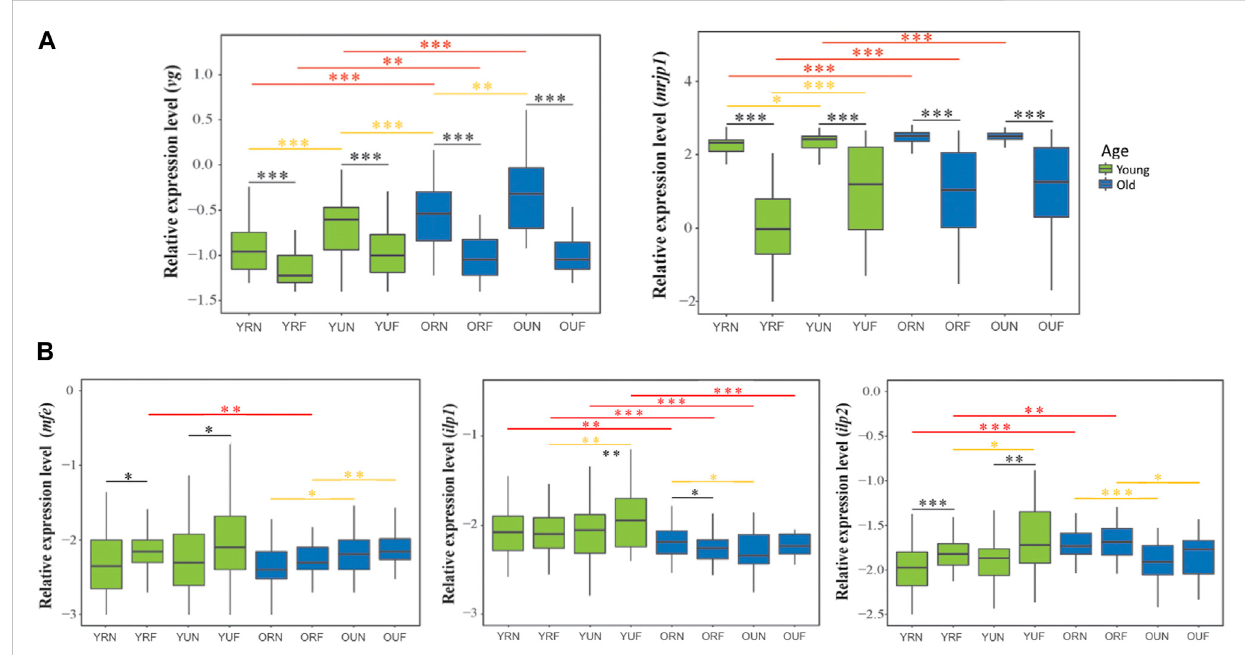
FIGURE 2 Relative mRNA levels of genes associated with physiological activity. The upper panel (A) compares the expression of genes associated encoding storage proteins. The lower panel (B) compares the expression of IIS-JH genes involved with hormonal regulation. The y -axes indicate log10- transformed relative expression levels. The x -axes show the age/nutritional/behavioral groups: young (Y), old (O), nurses (N), foragers (F), pollen- restricted (R) and (U) pollen-restricted. The age of bees referred to as “ young ” and “ old ” is 2-week-old and 3-week-old, respectively. Ribosomal protein Rps5 wasusedasaninternalcontrol.Boxesshowthe fi rstandthirdinterquartile ranges. Alinerepresentsthemedian.Whiskersinclude thevalues of 90% of the samples. Black, yellow and red asterisks illustrate signi fi cant differences between behavioral, nutritional, and age groups. * p < 0.05; ** p < 0.01. *** p <